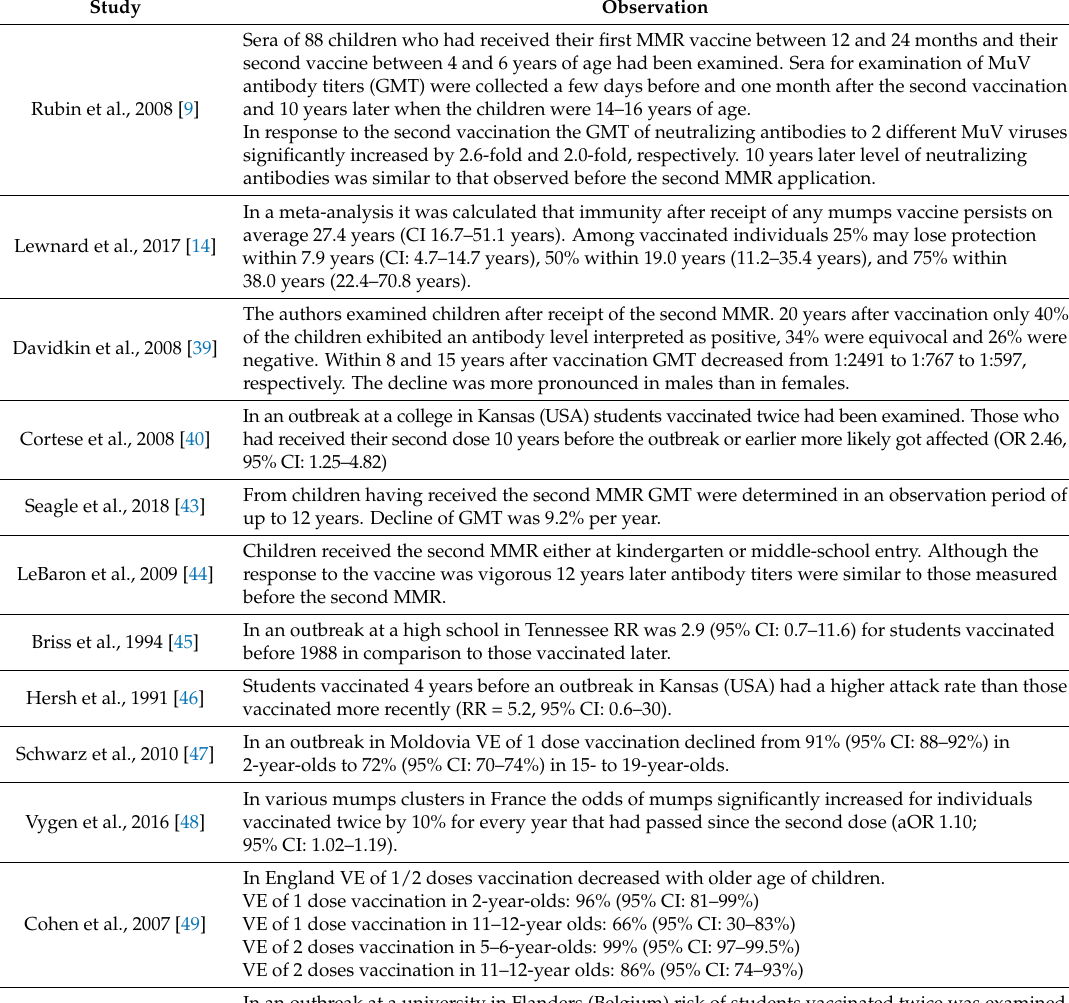
Table 2. Studies indicating waning immunity as a major risk factor of mumps in the MMR vaccination era. The studies were obtained through a “pubmed” search using the terms “mumps” AND “vaccination” AND “waning immunity” [42]. Data were accessed on 24 March